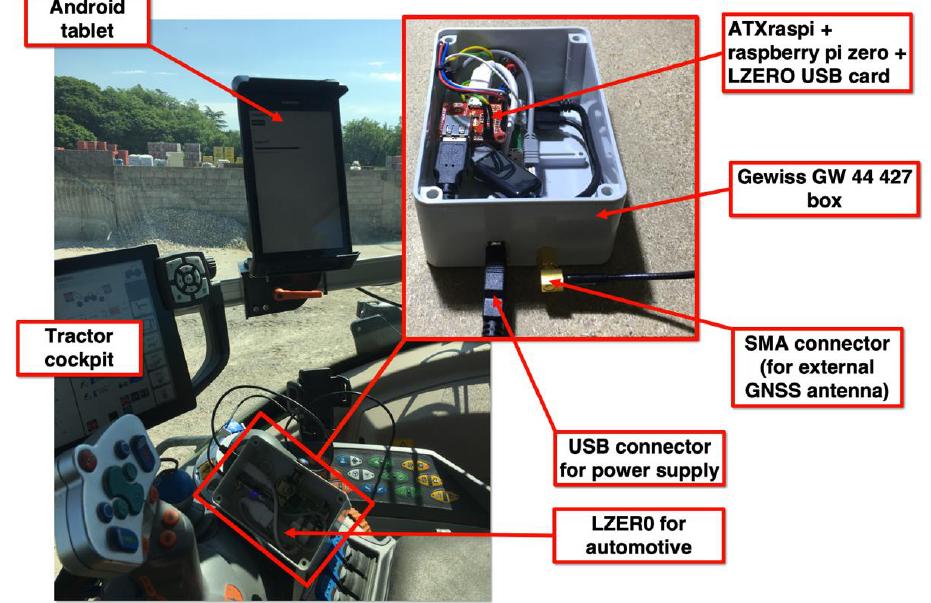
Figure 4. Automotive LZER0 model mounted on agricultural machinery. We installed the electronics in a Gewiss GW44427 industrial box (pictured top center), including the LZER0 USB board, the Raspberry Pi Zero W SBC, and the ATXraspi board. The ATXraspi board controls the power-on and power-off operations for the entire system, including safe shutdown operations for the Linux SBC. The system is powered by a USB plug connected to a 24V – 5V converter, and everything is powered by the machinery’s batteries. In the cockpit (on the left side of the picture) of the machinery, above which we installed the GNSS antenna, an Android tablet with Internet access is used to retrieve GNSS corrections from a remote caster and forward them to the LZER0 device. The same tablet is used to display the exact positions of the machinery in real-time and to guide the vehicle.